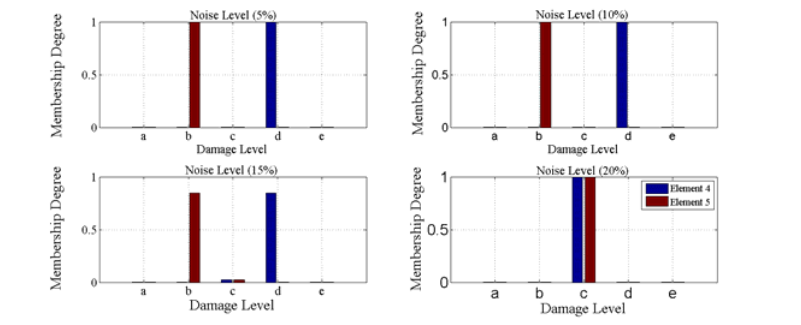
Fig. 14. Damage identification of case 3 with damage degree